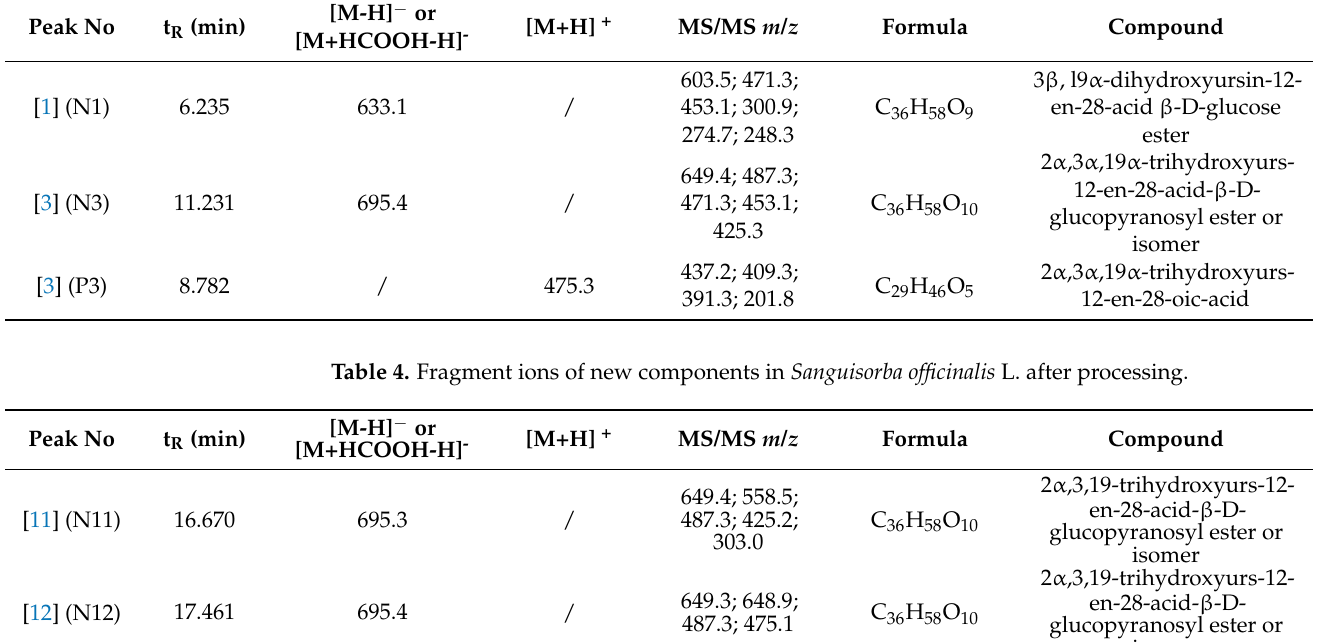
Table 3. Fragment ions of disappeared components in Sanguisorba officinalis L. after processing. Peak No